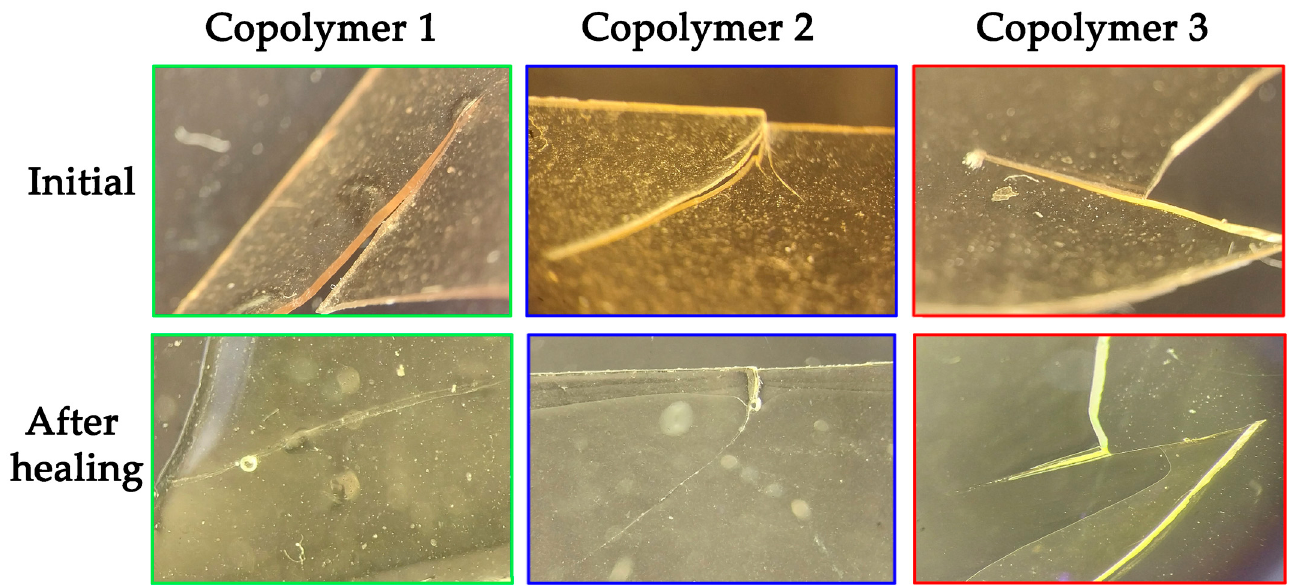
Figure 11. Optical microscopic images of autonomous internal healing.